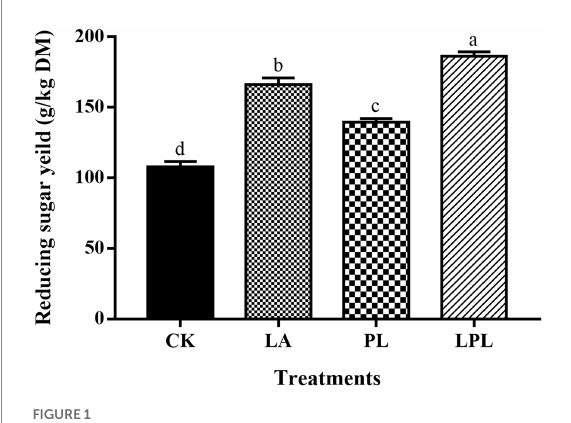
FIGURE 1 Reducing sugar yield of alfalfa silage treated with or without additives after enzymatic hydrolysis. CK, no additives; LA, laccase; PL, Pediococcus pentosaceus ; LPL, laccase + Pediococcus pentosaceus . Different letters (a–d) above the column were significant ( p <